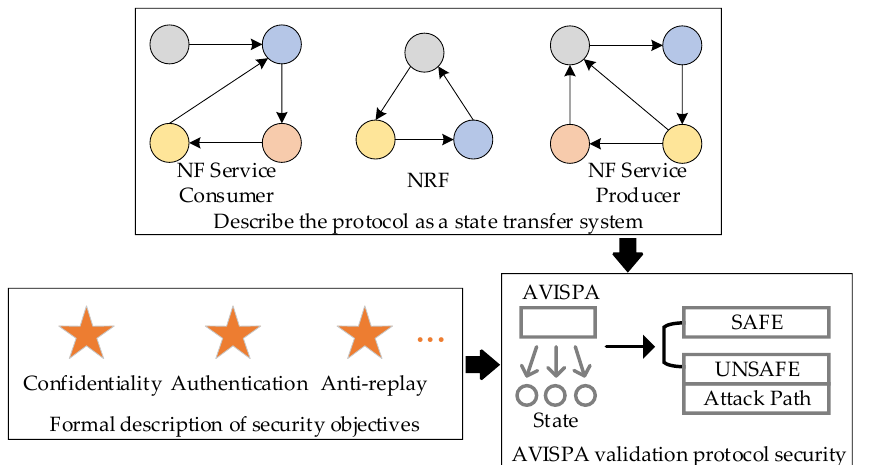
Figure 8. A security analysis model of NF service access protocol based on AVISPA.